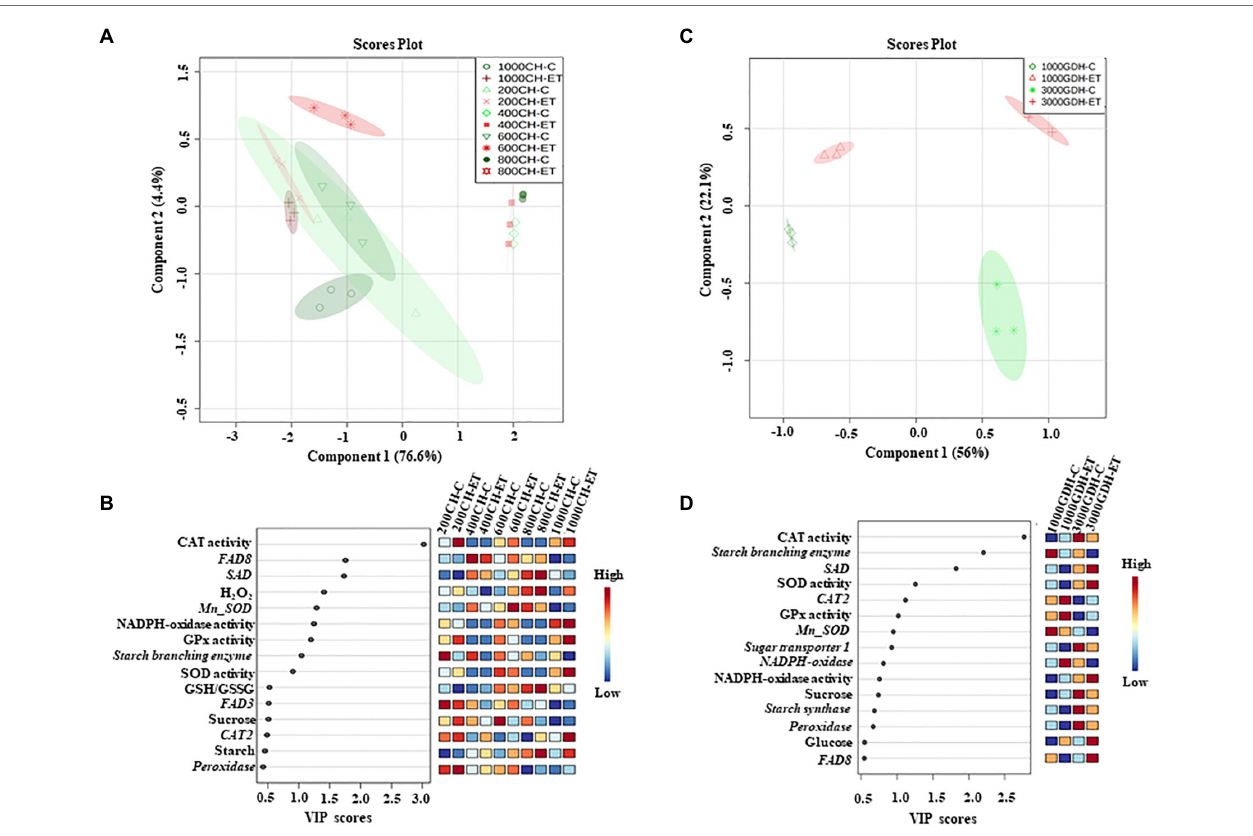
FIGURE 8 | 2D score plot of partial least squares-discriminate analysis (PLS-DA) during endodormancy (A) and ecodormancy (B) . Significant factors that contributed to component 2 with variable importance in projection (VIP ≥ 0.5) measure in PLS-DA during endodormancy (C) and ecodormancy (D) . The color boxes on the right indicate the relative concentrations of each variable under this study. C: control; ET: ethephon; CH: chilling hours; GDH; growing degree hours; and VIP: variable importance in